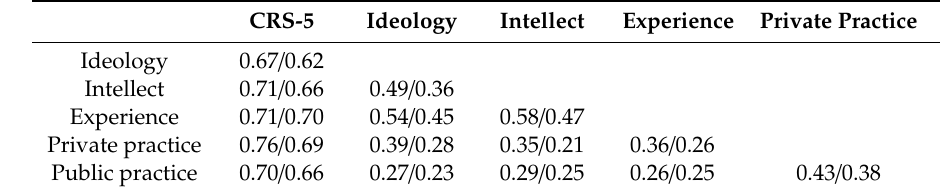
Table 4. Correlations of the core dimensions of the CRS-5 in the Christian orthodox samples in the years 2012 and 2018. CRS-5 Ideology Intellect Experience